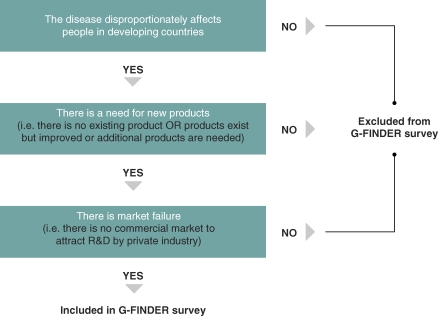
Three-Step Filter To Determine Scope of Neglected Diseases Covered by G-FINDER